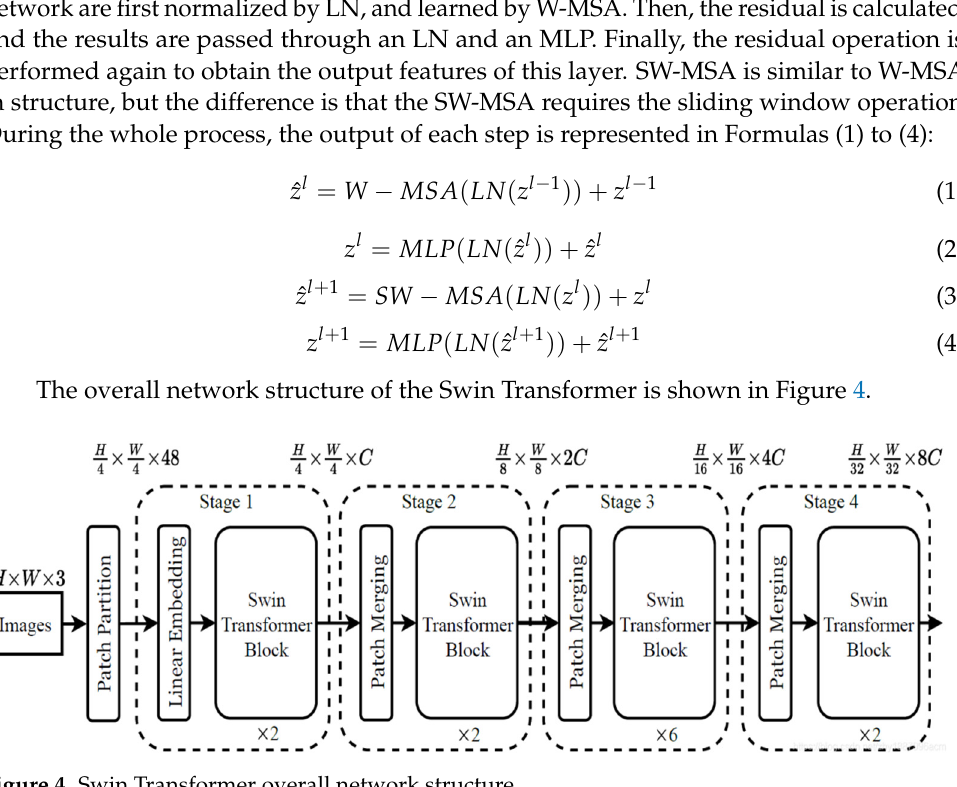
Figure 4. Swin Transformer overall network structure.